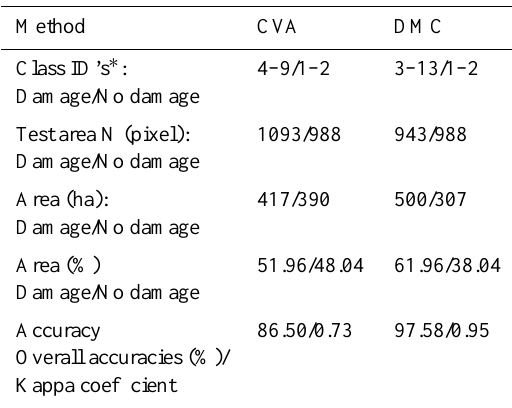
∗ class ID’s are taken from Table 2 from DMC and Table 4 for CVA,